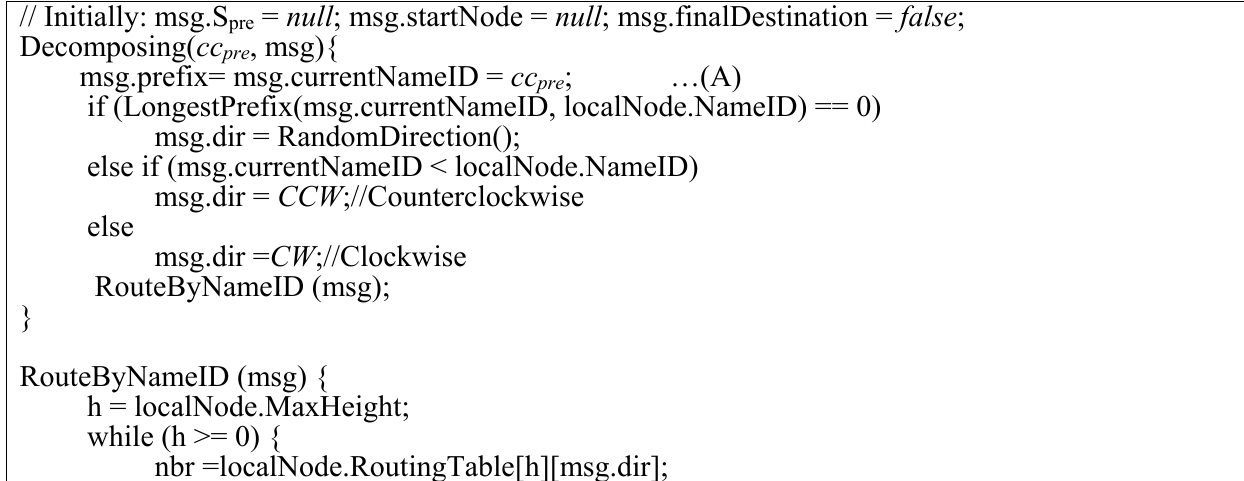
Algorithm 2. Decomposing a range of CC